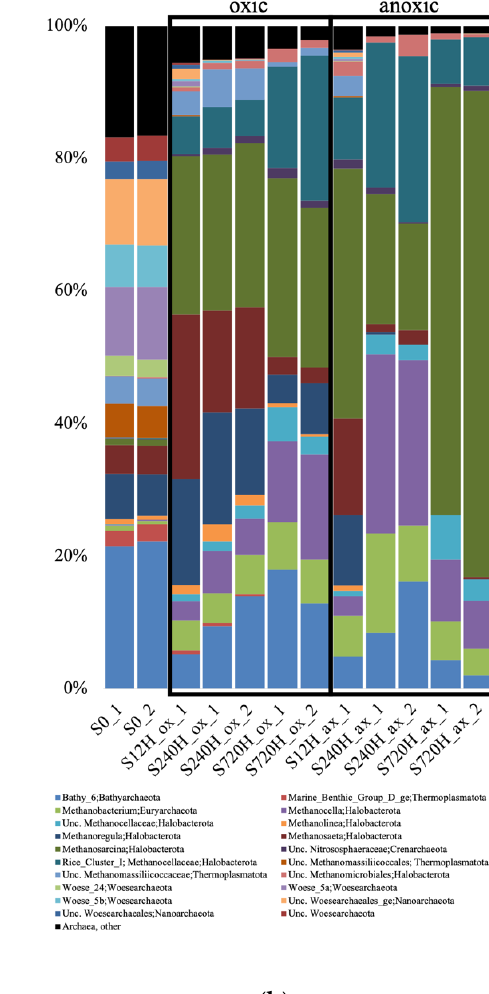
Figure 3. Time variation of DOC, S-SO 4 , N-NO 3 , DON, and TDN in oxic ( a ) and anoxic conditions ( c ), and of P-PO 4 ( b ) in oxic (blue) and anoxic (orange) conditions.